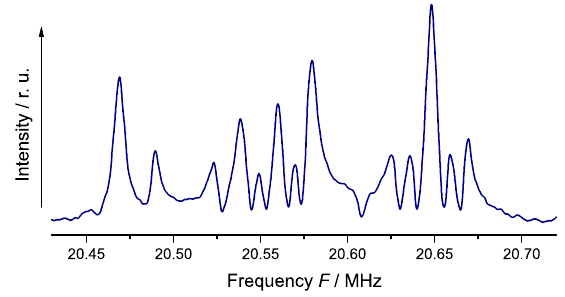
Figure 14. NQR spectrum for 115 In isotope in InSe for spin transition at a frequency of 20.5 MHz.